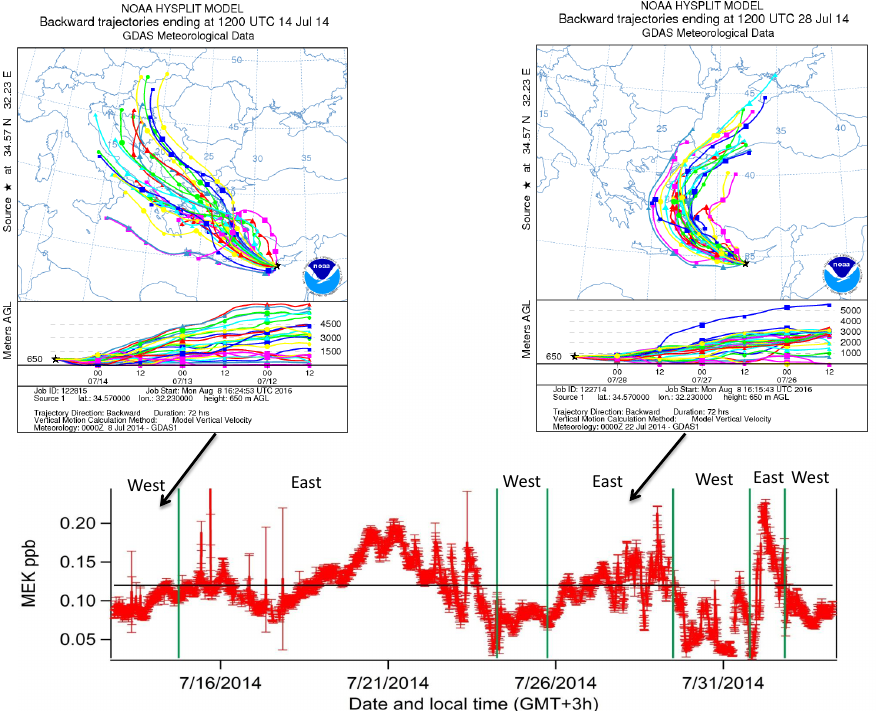
Figure 8. Timeline of MEK mixing ratios divided into periods when the air was coming from either eastern or western Europe. The HYSPLIT backward trajectories from 14 July and 28 August 2014 are shown based on the origin of the air masses. The black line represents the average of the whole